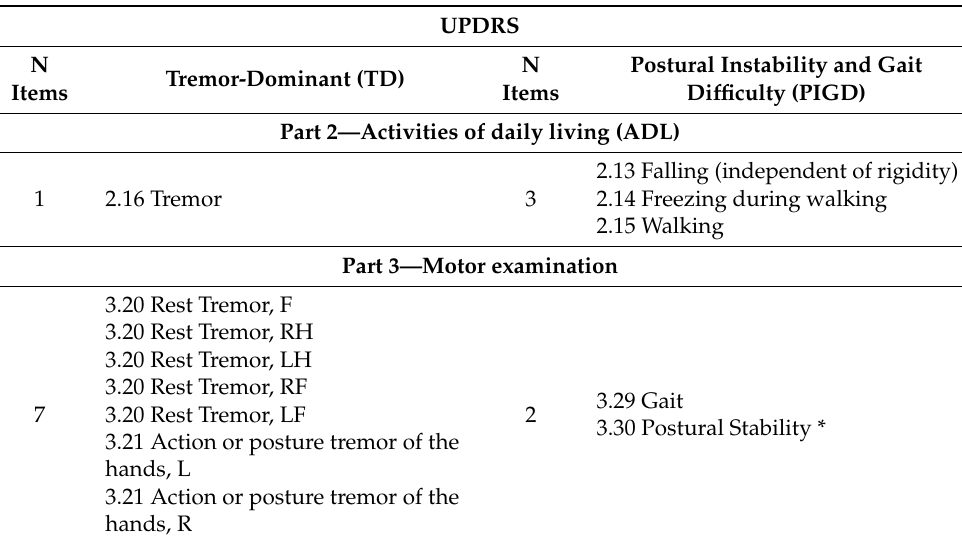
Table 2. Items of the UPDRS to classify the motor subtypes Tremor Dominant (TD) and Postural Instability (PIGD) in PD